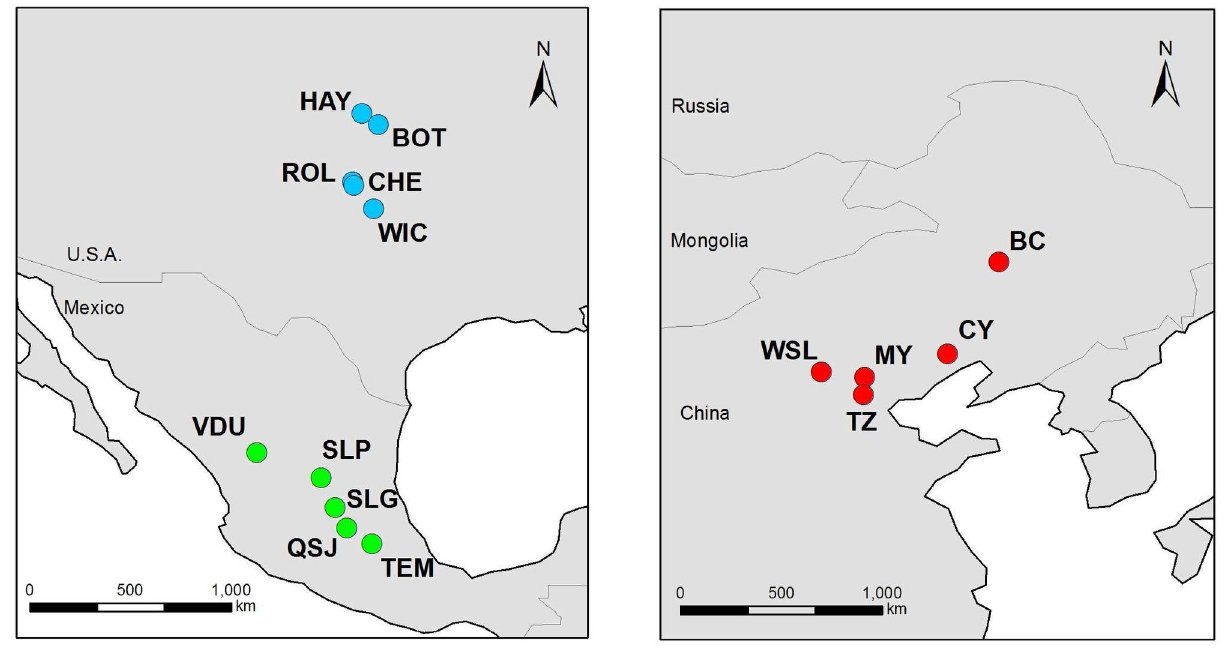
Figure 1. Map showing the location of the 15 sampled populations of Solanum rostratum used in this study. Left panel: Mexican (native, green circles) and U.S.A. populations from the U.S.A. (residence time >130 years, blue circles). Right panel: Chinese populations (residence time <31 years, red circles). Details of localities and population codes are provided in Table 1. doi: